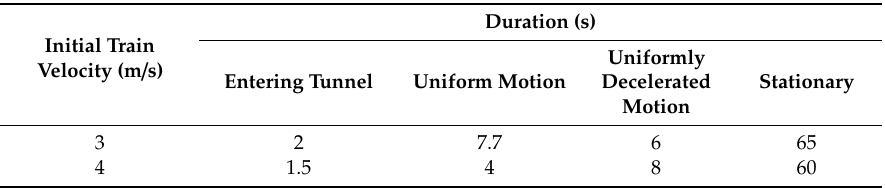
Table 2. Running states of the model